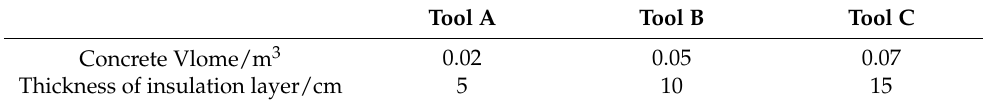
Figure 3. The simulation tools. Table 2. The concrete volume and the thickness of insulation layer selected for the